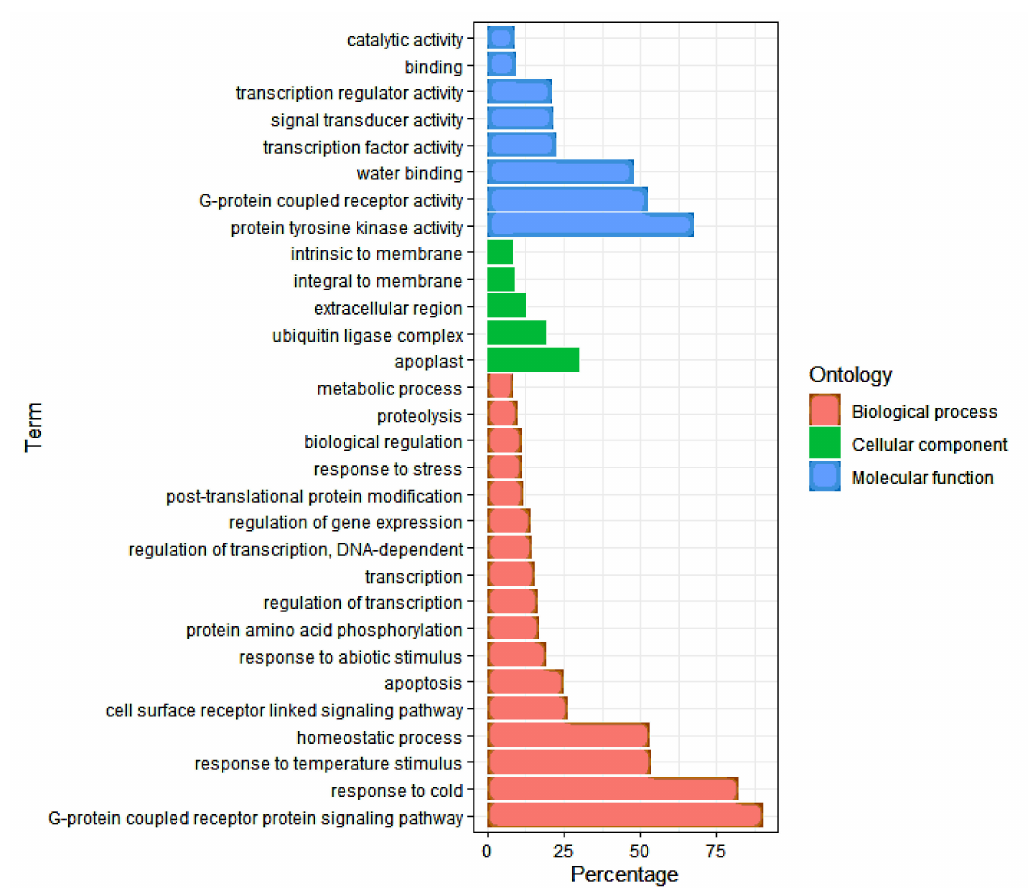
Figure 5. Gene Ontology (GO) enrichment analysis of the 1656 common cold-responsive genes. The GO terms shown here are the top-most biological process (BP), molecular function (MF), and cellular component (CC) categories.